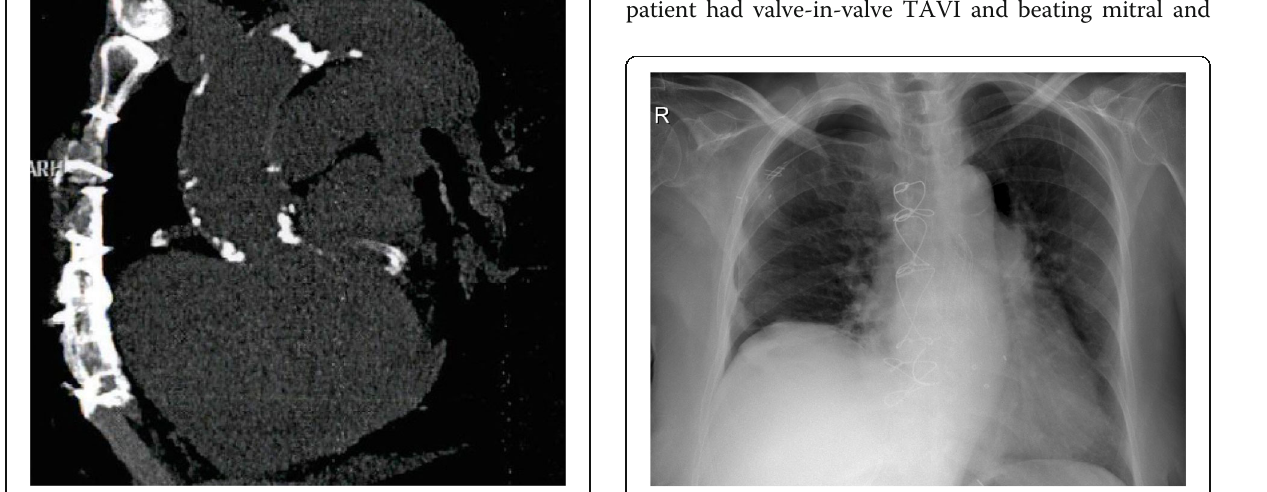
Fig. 1 Preoperative computed tomography scan of the chest showing calcific root, ascending aorta and arch